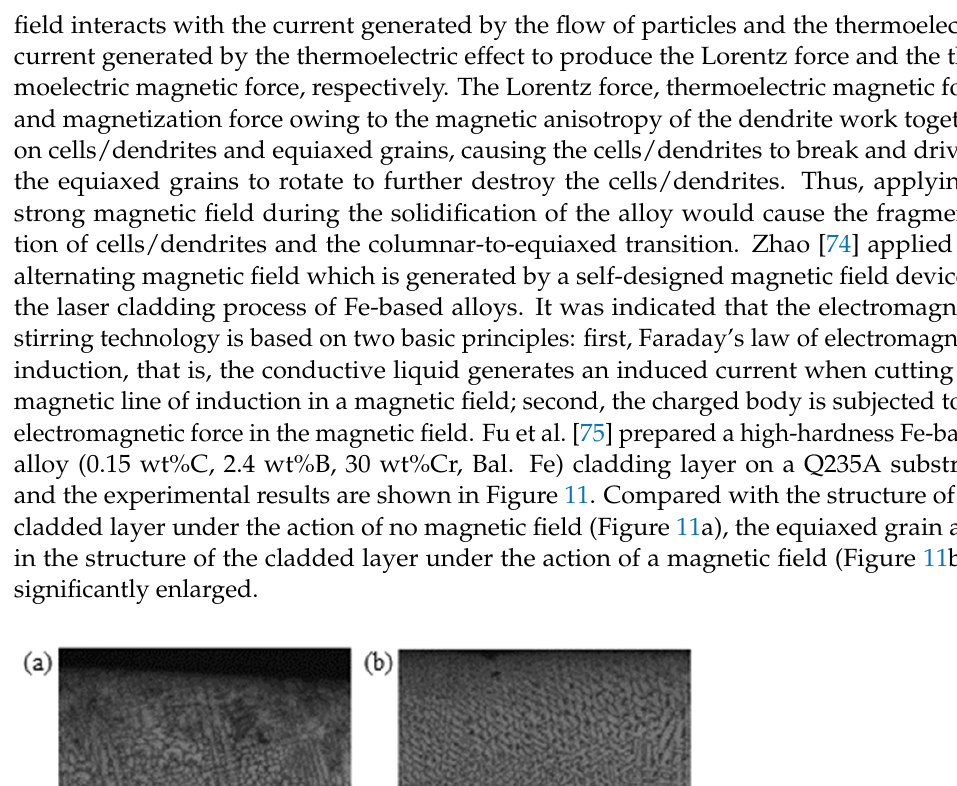
Table 1. The coupling of physical fields and its effects.